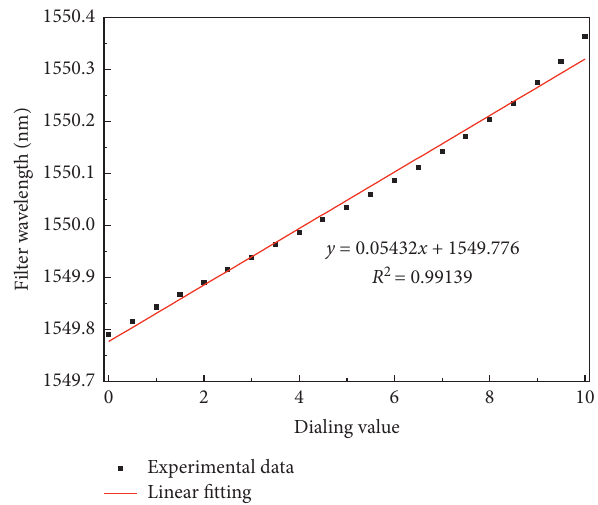
Figure 4: Measuring the output filter wavelength versus the input dialing